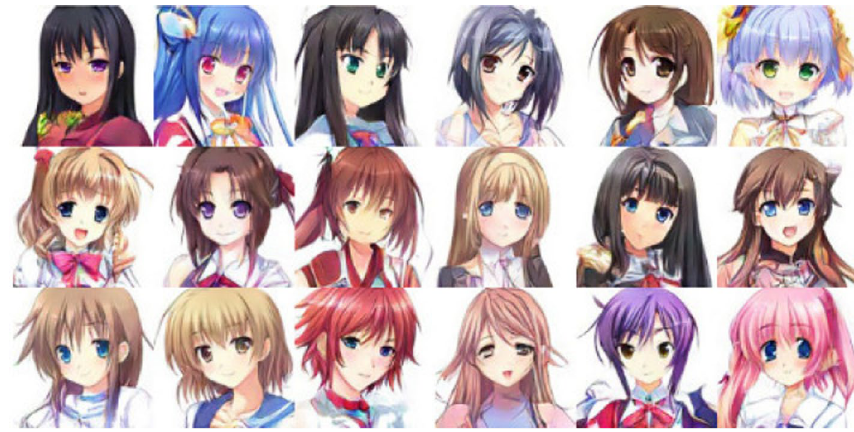
Fig. 18 Anime samples generated by